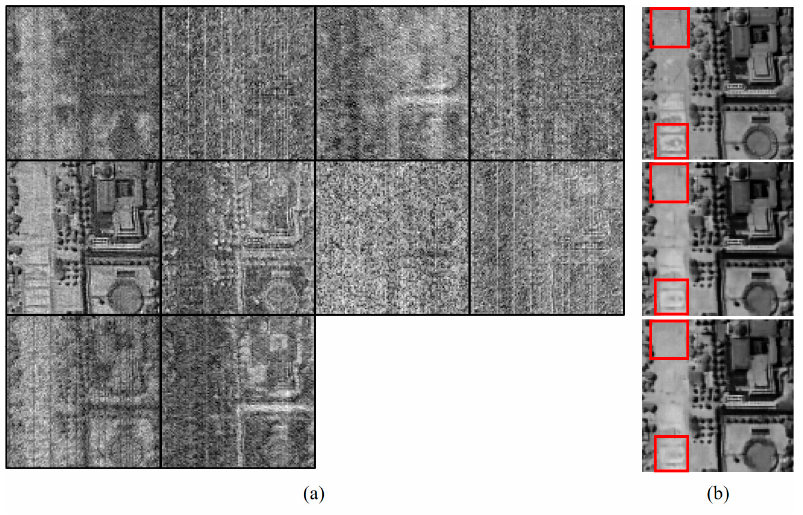
Figure 15. Base visualization. ( a ) Visualization of basis vectors; ( b ) ground truth (up), denoising result with OSPA (middle) and result without OSPA (down).